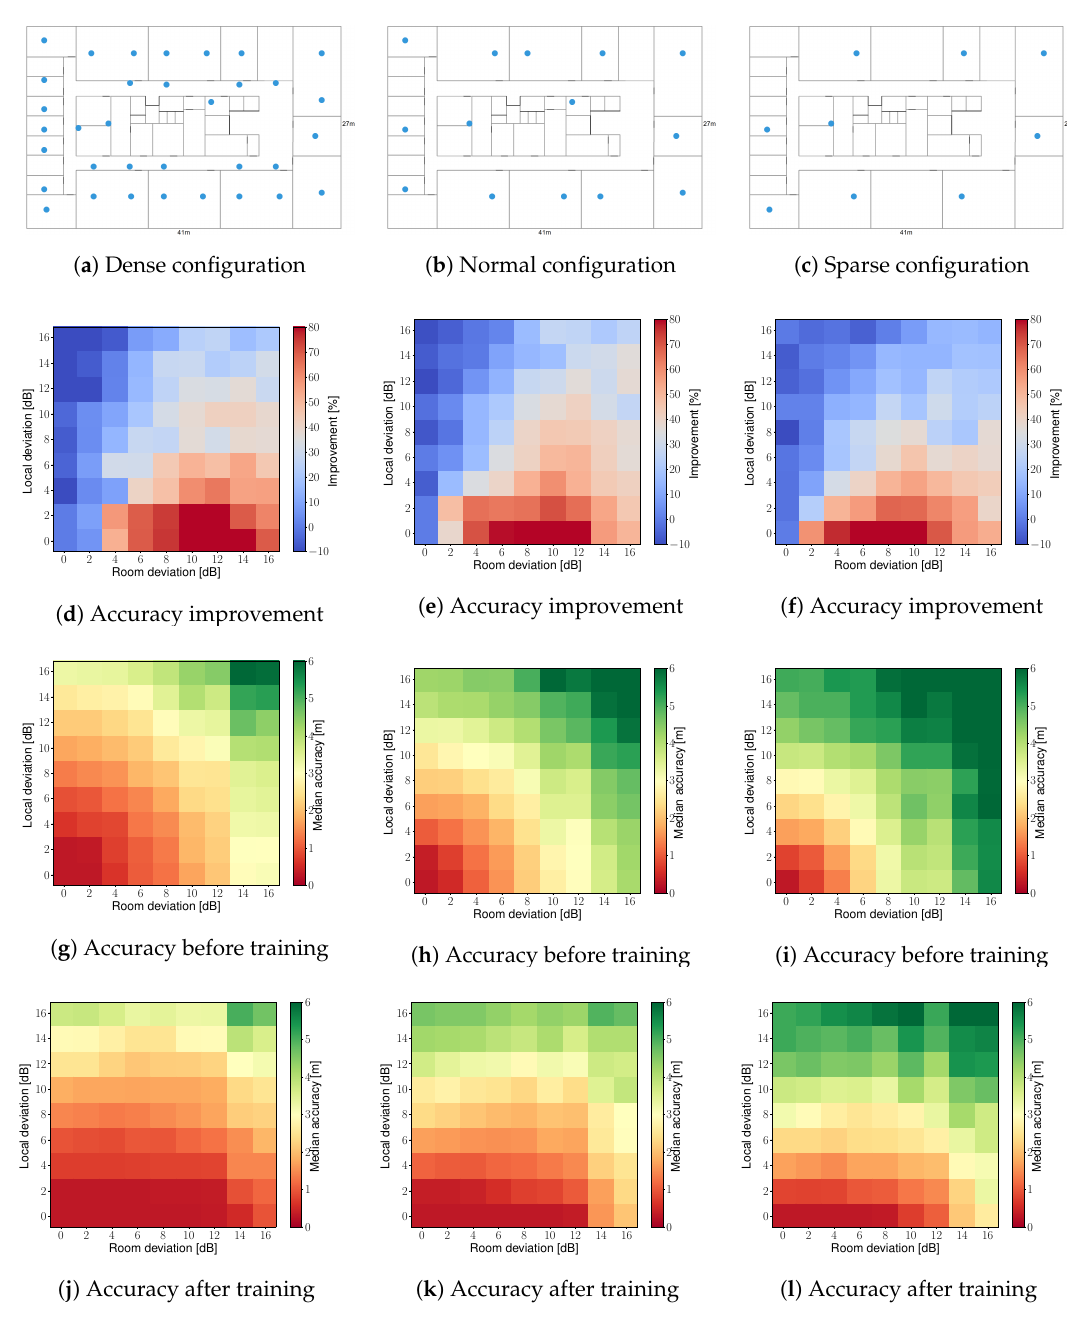
Figure 5. Location of the access points for the simulated scenarios with 35, 15, and 9 fixed access points: dense ( a ), normal ( b ), and sparse ( c ) configuration. The relative improvement in median accuracy after unsupervised learning with 1 h of unlabeled training data, evaluated on 1000 uniformly spread locations for the three scenario’s ( d – f ). The median accuracy before ( g – i ) and after learning ( j – l ) for the three scenario’s. The room deviation ( x -axis) and local deviation ( y -axis) vary from 0 dB to 16 dB in steps of 2